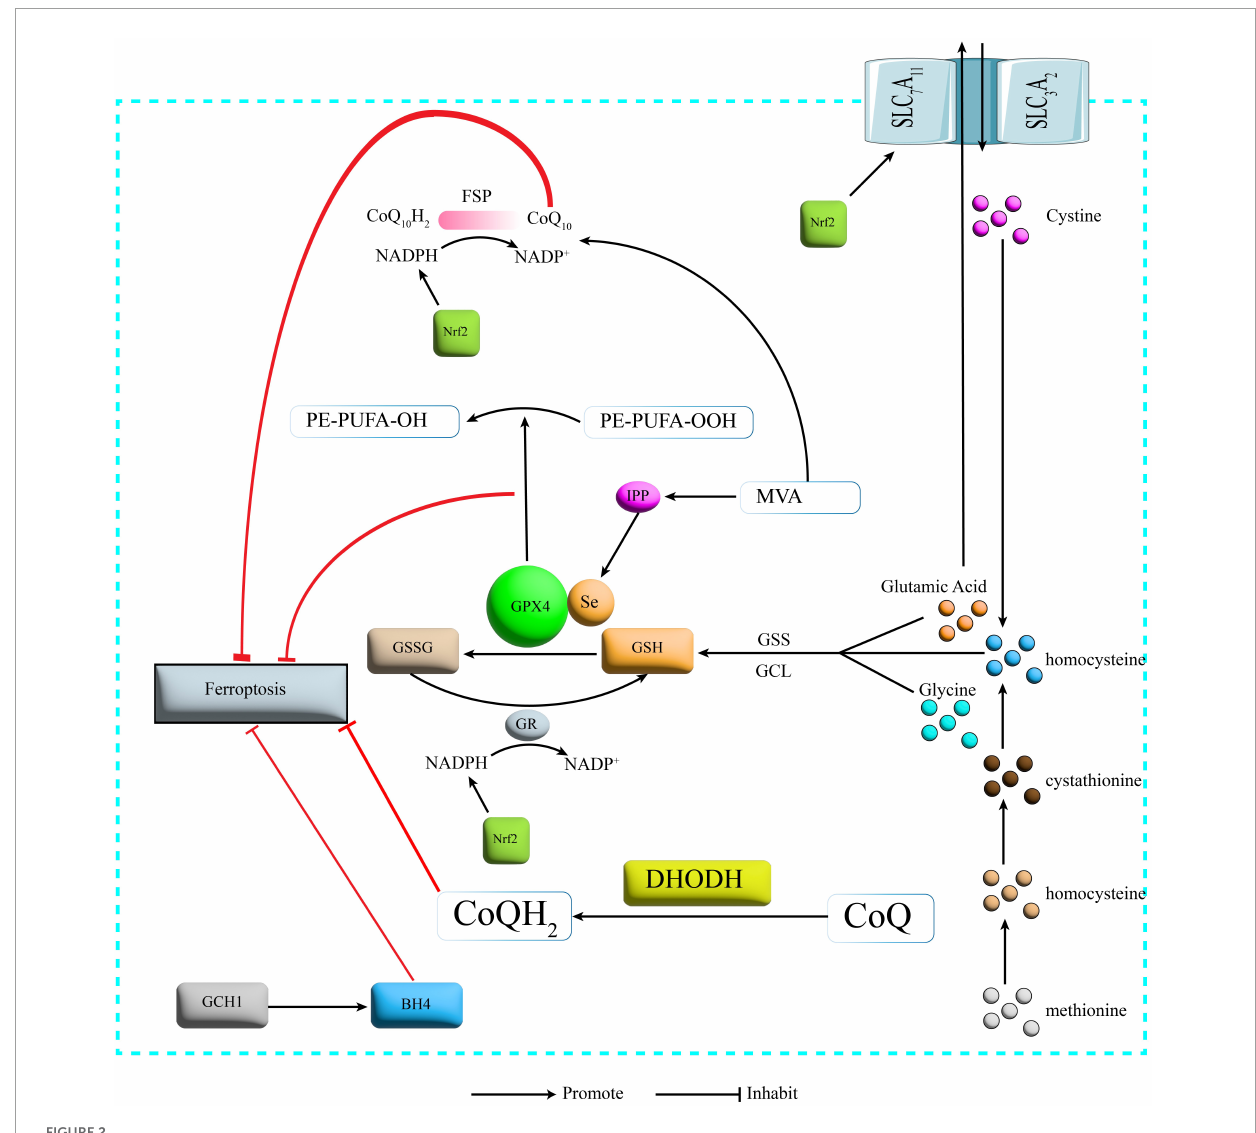
FIGURE2 Protection mechanism for Ferroptosis. SLC7A11, recombinant solute carrier family 7, member 11; SLC3A2, recombinant solute carrier family 3, member 2; GSS, glutathione synthetase; GCL, glutamate cysteine ligase; GSH, glutathione; GPX4, glutathione peroxidase 4; GR, glutathione reductase; GSSG, glutathione oxidized; NADPH: nicotinamide adenine dinucleotide phosphate; NADP, nicotinamide adenine dinucleotide phosphate; FSP1, Ferroptosis inhibitory protein 1; CoQ10, Coenzyme Q10; DHODH, dihydroorotate dehydrogenase; CoQ Coenzyme Q; GCH1, GTP cyclohydrolase-1; BH4, tetrahydrobiopterin; IPP, isopentenyl pyrophosphate; MVA, mevalonate; Nrf2, nuclear factor erythroid 2-related factor